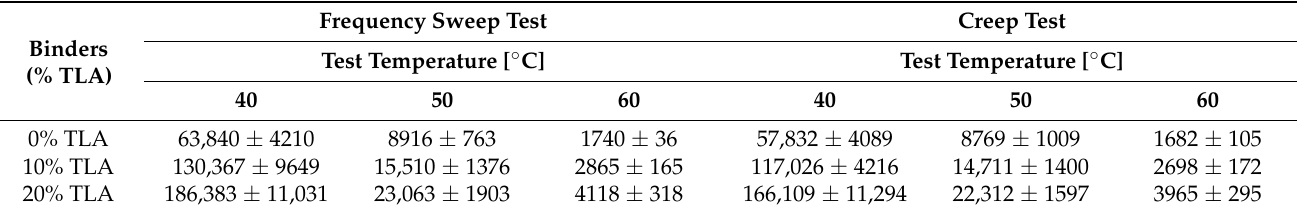
Table 4. ZSV of TLA-modified binders.